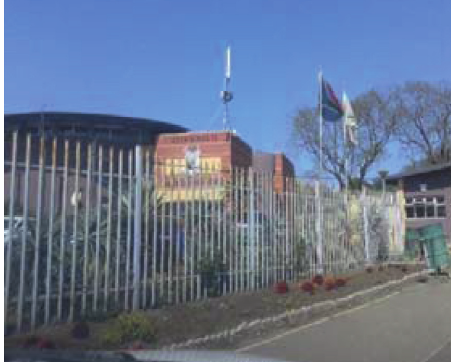
Figure 5: Local municipality: site two.